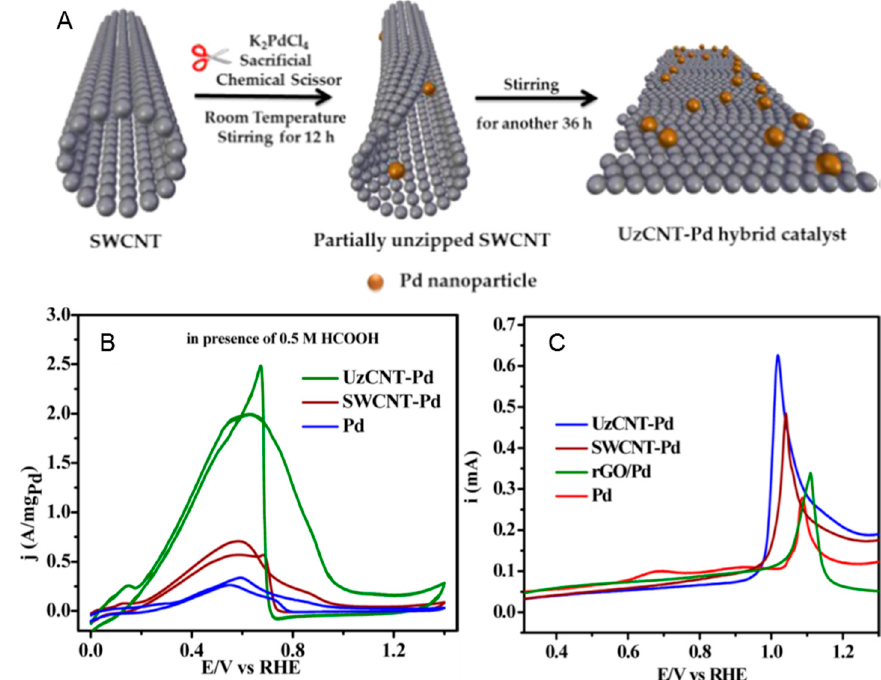
Figure 5. ( A ) Schematic illustration of the unzipping of single-walled carbon nanotubes (SWCNTs). ( B ) Cyclic voltammograms for formic acid electrooxidation and ( C ) anodic sweep voltammograms for CO stripping. Reproduced with permission [69]. Copyright 2018, American Chemical Society.